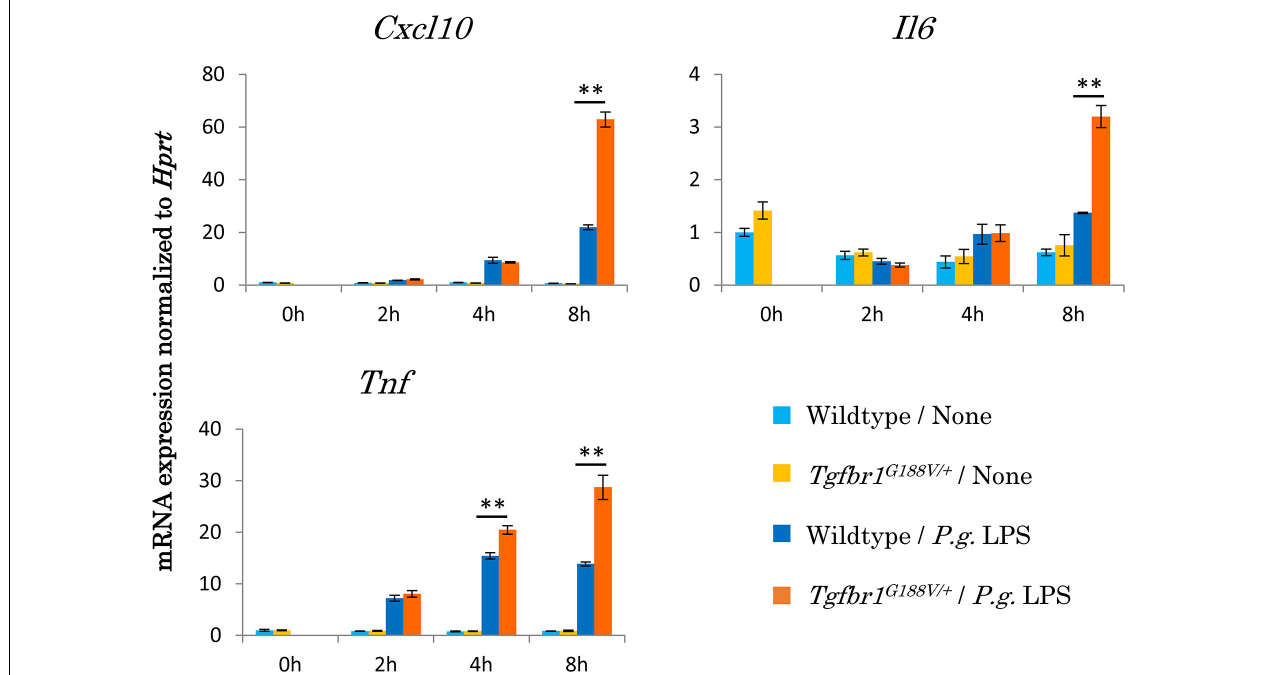
FIGURE 7 | Upregulation of inflammatory cytokine mRNA expression in peritoneal macrophages from Tgfbr1 G 188 V / + mice. Macrophages were harvested from the peritoneal cavity of 8-week-old male WT and Tgfbr1 G 188 V / + mice at 3 days after injection of thioglycolate. The peritoneal macrophages were stimulated with 1 µ g/ml P. gingivalis LPS for the indicated times and then total RNA was isolated for quantitative PCR analysis. Data represent means ± SD in triplicate assays. ∗∗ P < 0.01, compared with wildtype.